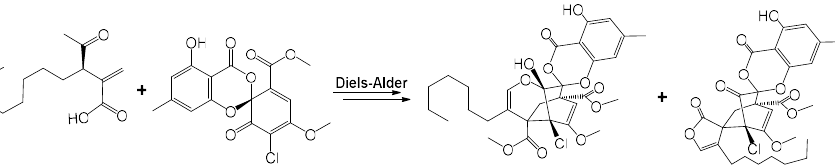
shown in Figure 3.